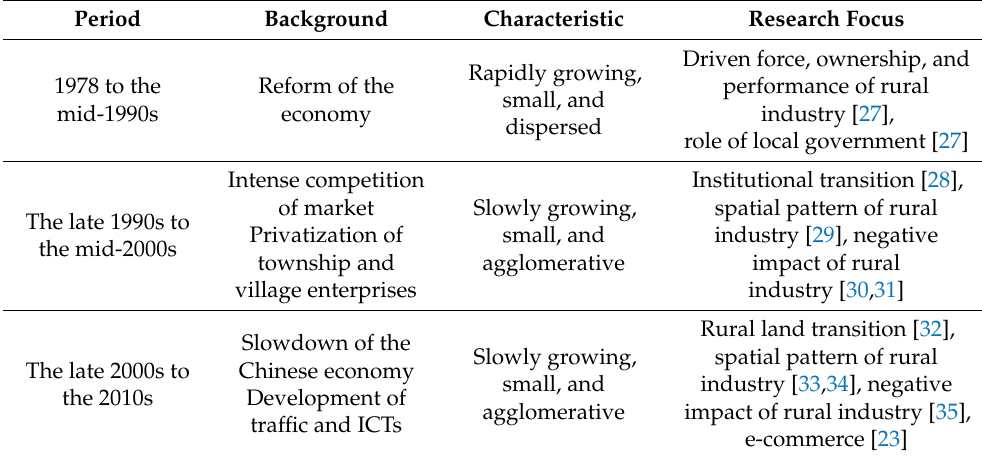
Table 1. Process of rural industrialization in China,